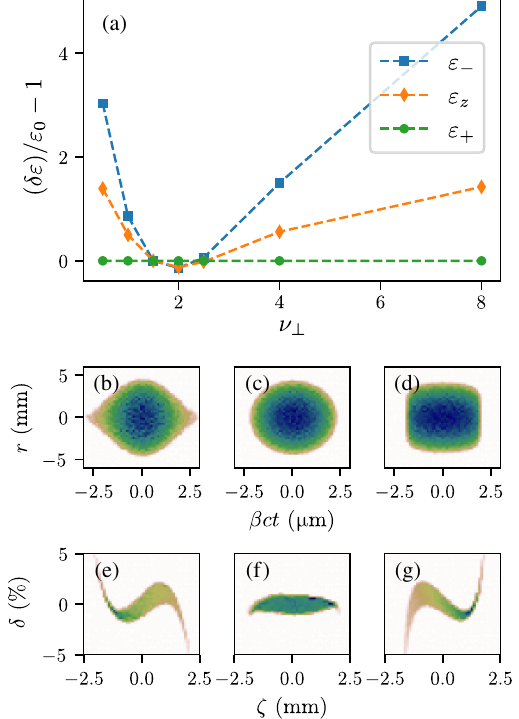
the longitudinal is insignificant. FIG. 7. Relative emittance dilution δε (here ε 0 represents the ε 0 nominal emittances reported in Table II obtained with the ellipsoidal distribution ν ⊥ ¼ 2 ) as a function of the exponent ν ð β ct; r Þ at ⊥ value in Eq. (23) (a). Spatiotemporal distribution the cathode surface (b – d) and longitudinal phase spaces (e – g) for ν ¼ 0 . 5 (b,e), 2 (c,f), and 8 (d,g). In plots (b,d), β represents ⊥ the reduced velocity at emission (i.e., associated with the excess kinetic energy) and t is the emission time.